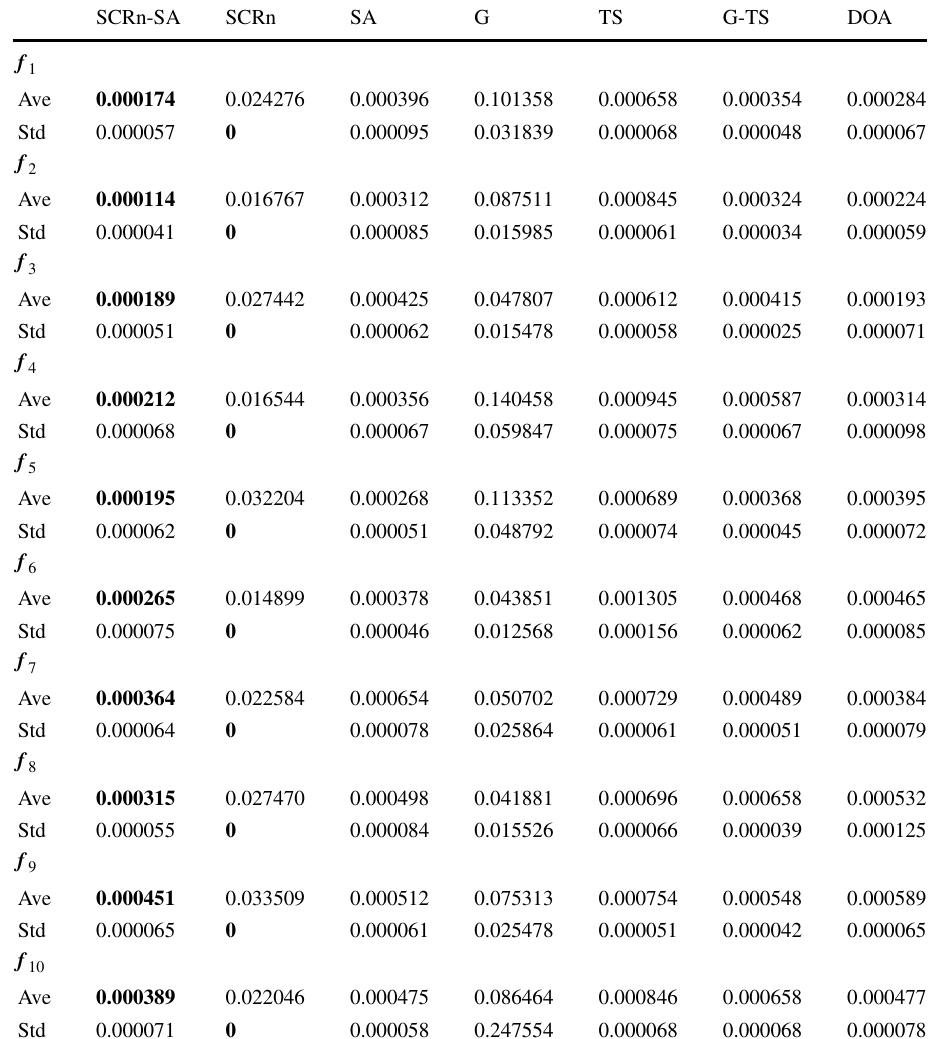
Table 4 Statistical results of SCRn-SA, SCRn, SA, G, TS, G-TS and DOA on small instances